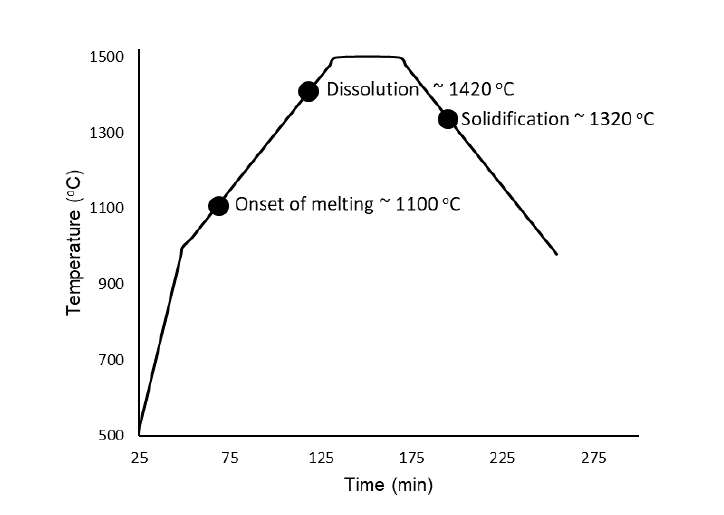
Figure 5. Temperature vs. time of the CoCrCu + Ni samples heated and imaged from 1000 °C to 1500 °C and back down to 1000 °C.